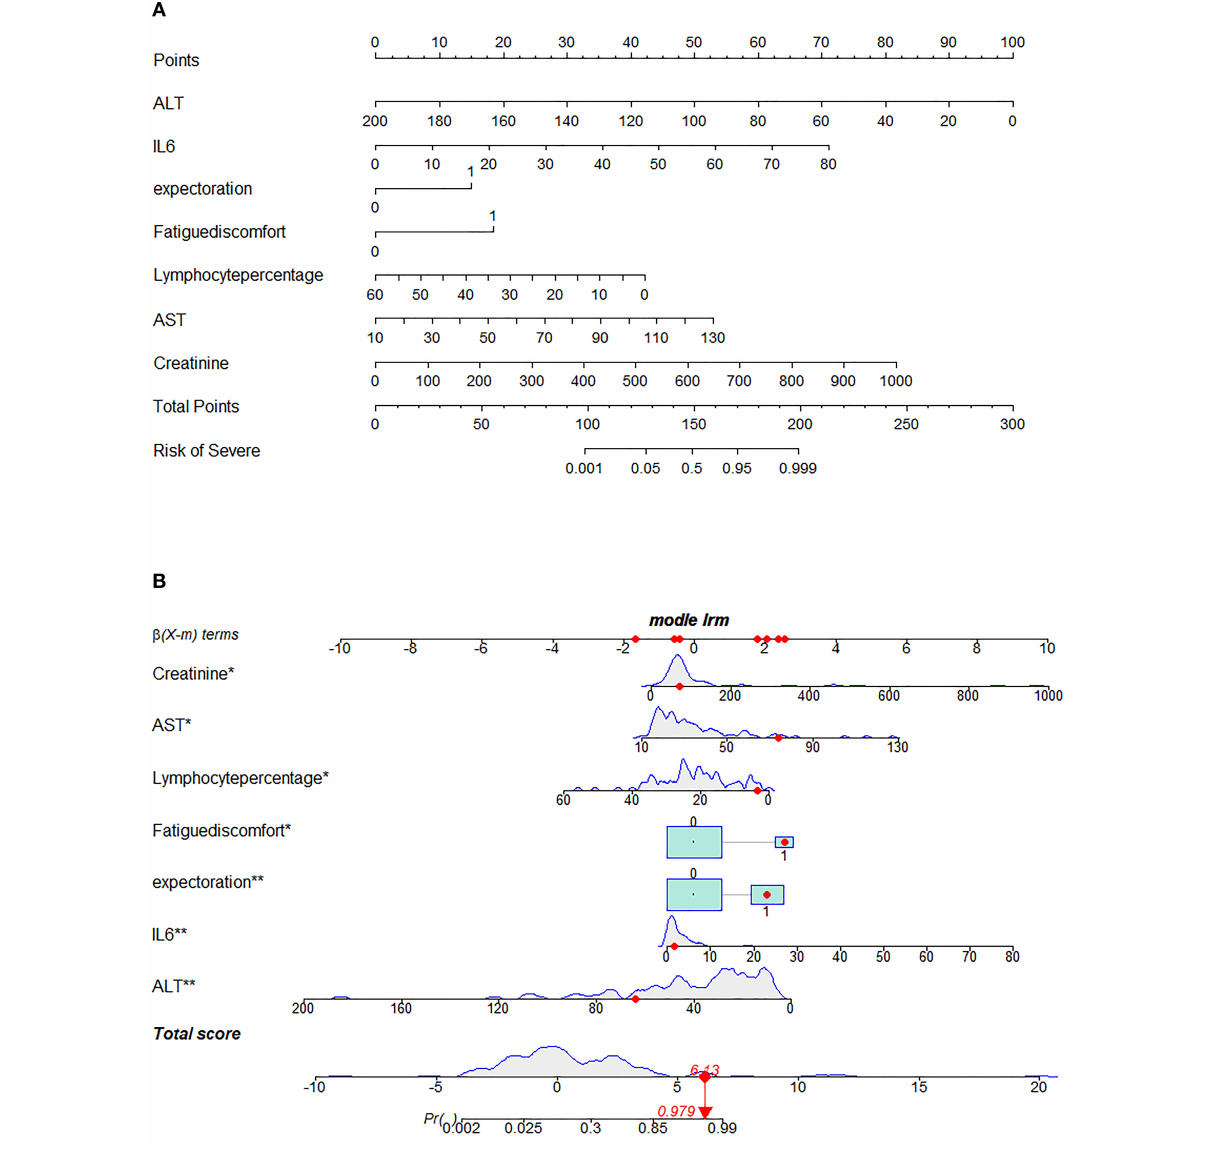
FIGURE 3 | Nomogram for predicting severe coronavirus disease 2019 (COVID-19). (A) To use the nomogram for an individual patient, the points (top gridline) for each predictor variable are first assigned and the total points calculated. A vertical line from this value on the Total Points gridline then provides a probability for predicting severe COVID-19. The results of the binary variable are encoded as 0 and 1, representing the absence and presence of this symptom, respectively. The calculation is further illustrated in (B) , which shows the results of a patient with certain laboratory findings; the probability of this patient progressing to severe COVID-19 is